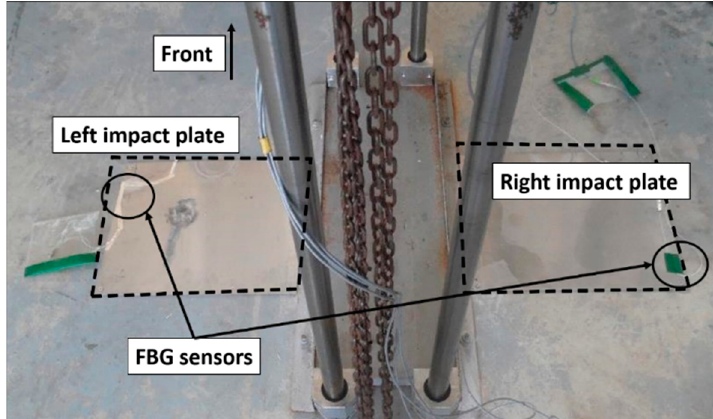
Figure 5. The two accelerometers placed on the top of the trolley.